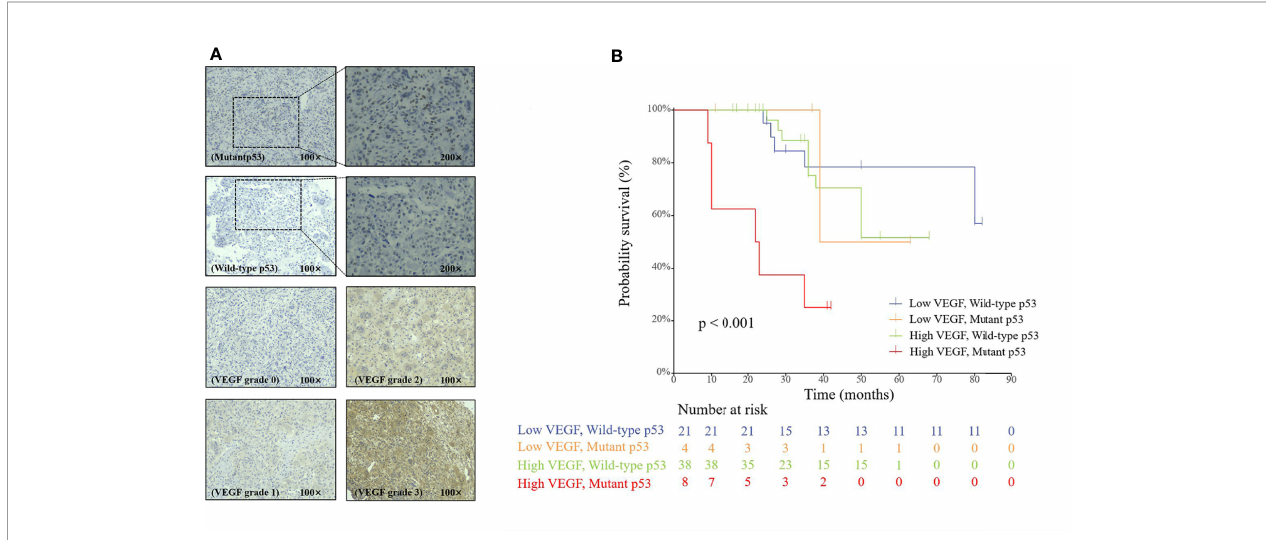
FIGURE 3 | (A) Immunohistochemical staining of p53 and VEGF in spinal GCTB. (B) The Cox proportional hazards regression analysis of the p53 and VEGF groups.